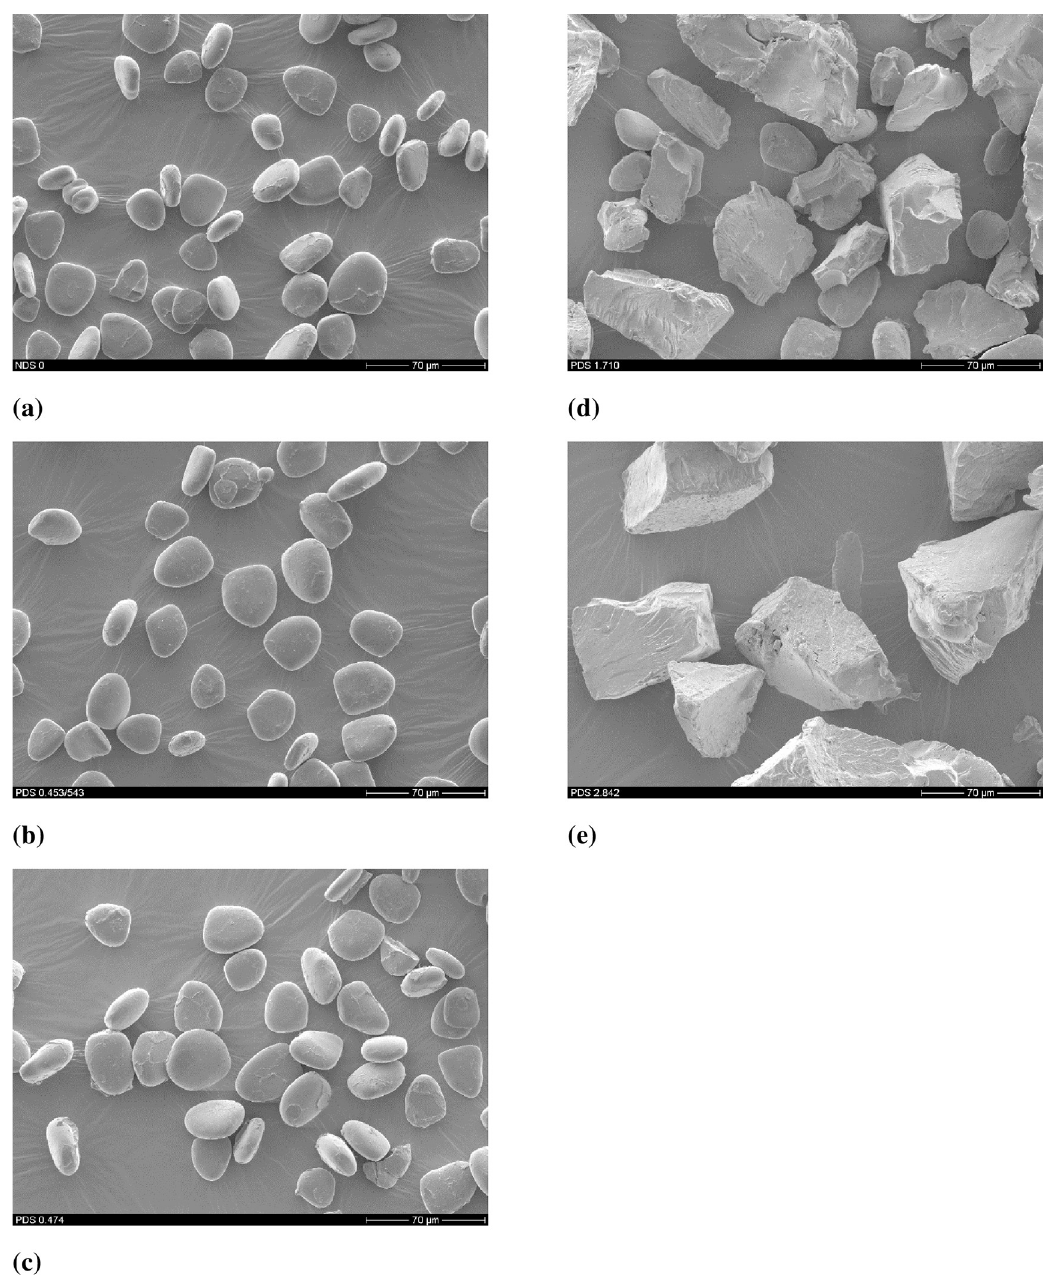
Fig 4. Scanning electron micrographs (2000X) of native DAS (a) NDAS and PDAS with different DS: (b) PDAS (DS = 0.453), (c) PDAS (DS = 0.474), (d) PDAS (DS = 1.710), (e) PDAS (DS = 2.842). propylated starches at high DS (DS = 1.710 and DS = 2.842) was much smaller than the native starch and did not increase significantly (p > 0.05) with an increase in temperature as in native starch or PDAS of lower DS as depicted in ( S4 Fig ).